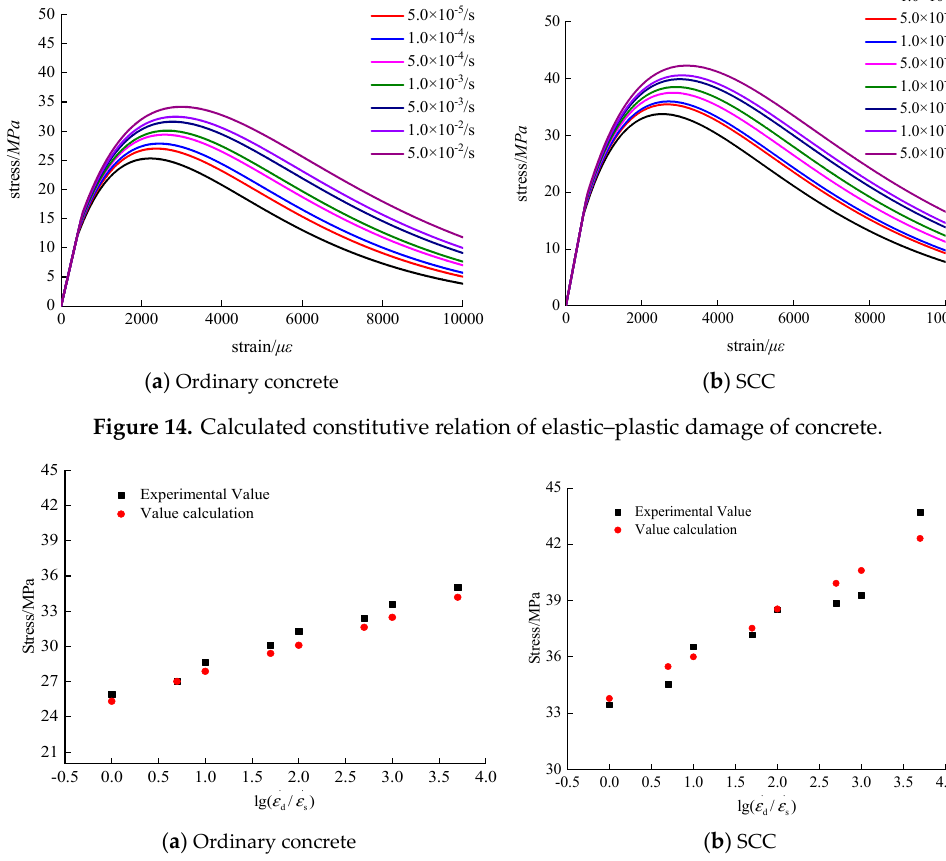
Figure 15. Calculated and theoretical peak compressive stress of concrete.